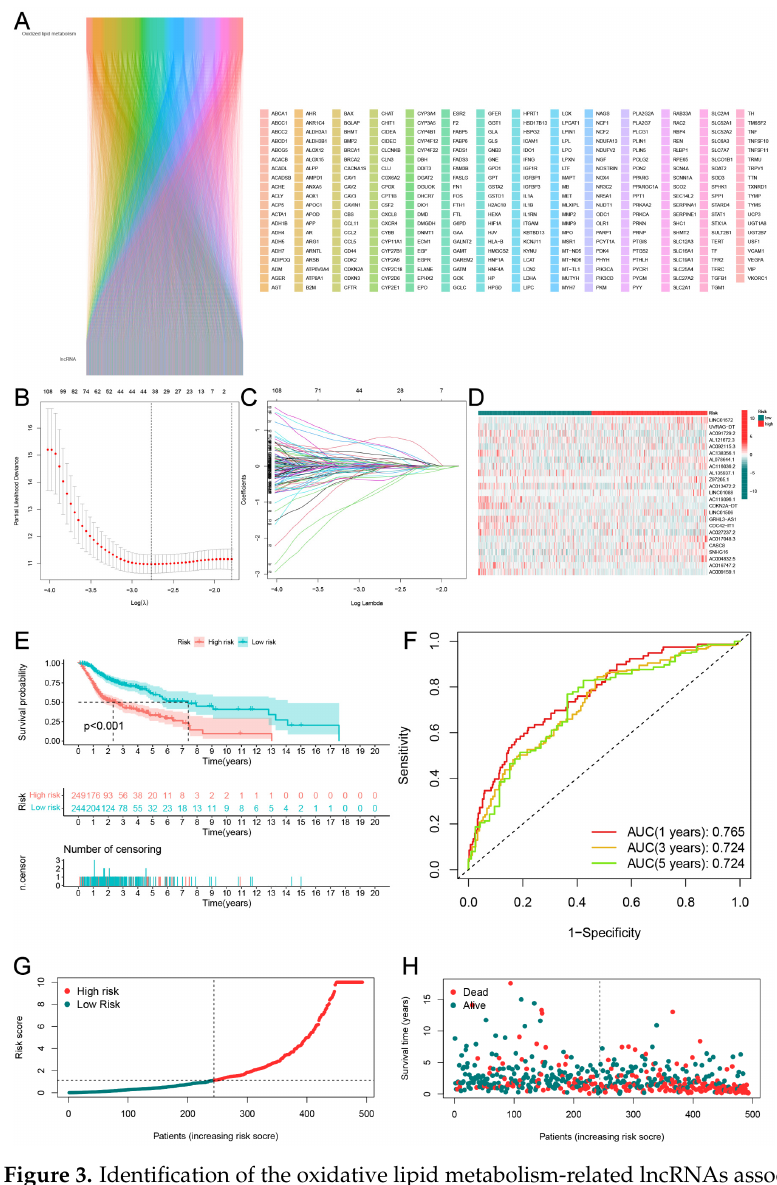
Figure 3. Identification of the oxidative lipid metabolism-related lncRNAs associated with prognosis in HNSCC. ( A ) Prognostic lncRNA extracted by univariate Cox proportional hazard regression analysis. ( B , C ) LASSO-Cox regression model for screening the process of oxidative lipid metabolism-related lncRNAs. ( D ) Heat map showing the expression of 24 lncRNAs between the high-risk and low-risk groups. ( E ) Kaplan–Meier curves for the survival status and survival time in the high-risk and low-risk groups for HNSCC. ( F ) The ROC curves show the predictive efficiency of the risk scores for patient survival at 1, 3, and 5 years. ( G , H ) The distribution of risk scores, survival status, and survival time in patients with HNSCC.